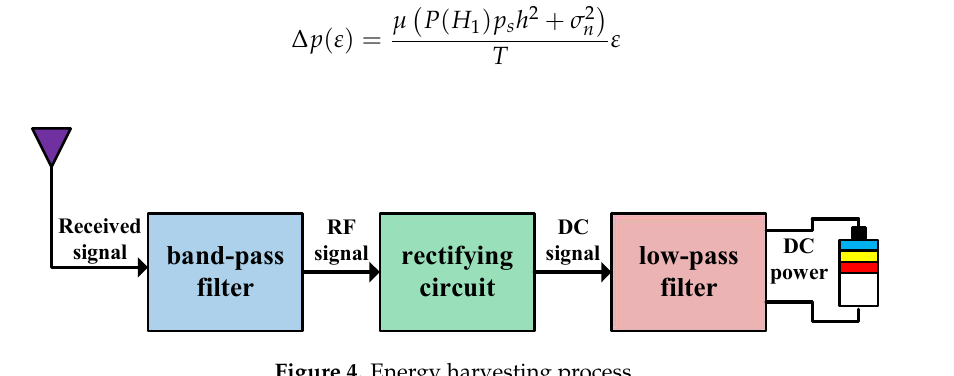
Figure 4. Energy harvesting